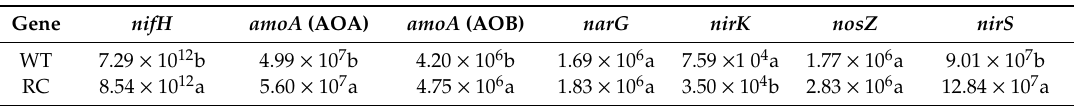
Table 4. Copy numbers of N cycle related genes in rice rhizosphere soil under no nitrogen treatment in buckets.